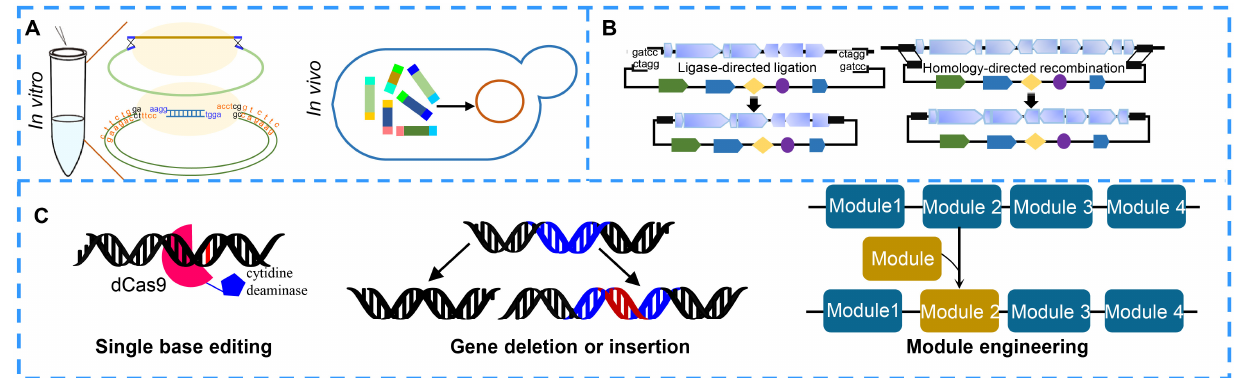
Figure 5. Tools for pathway reconstruction or engineering of natural product. ( A ) DNA assembly tools for assembling multiple DAN fragments of biosynthetic gene cluster in vivo or in vitro. ( B ) Capturing biosynthetic gene clusters of natural products by direct cloning. ( C ) Genome editing for improving natural products through single-base editing, gene deletion, gene insertion and module editing using CRISPR tools.